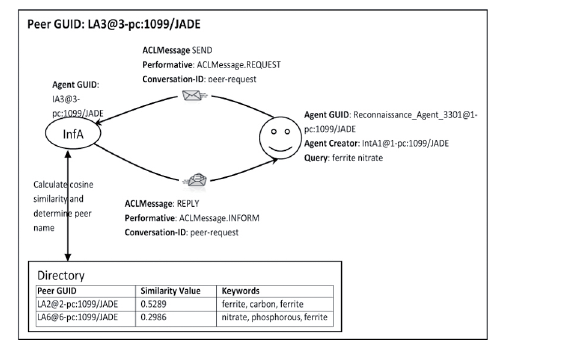
Fig. 3. Interactions between multiple agents for resource discovery and realisation of an overlay network